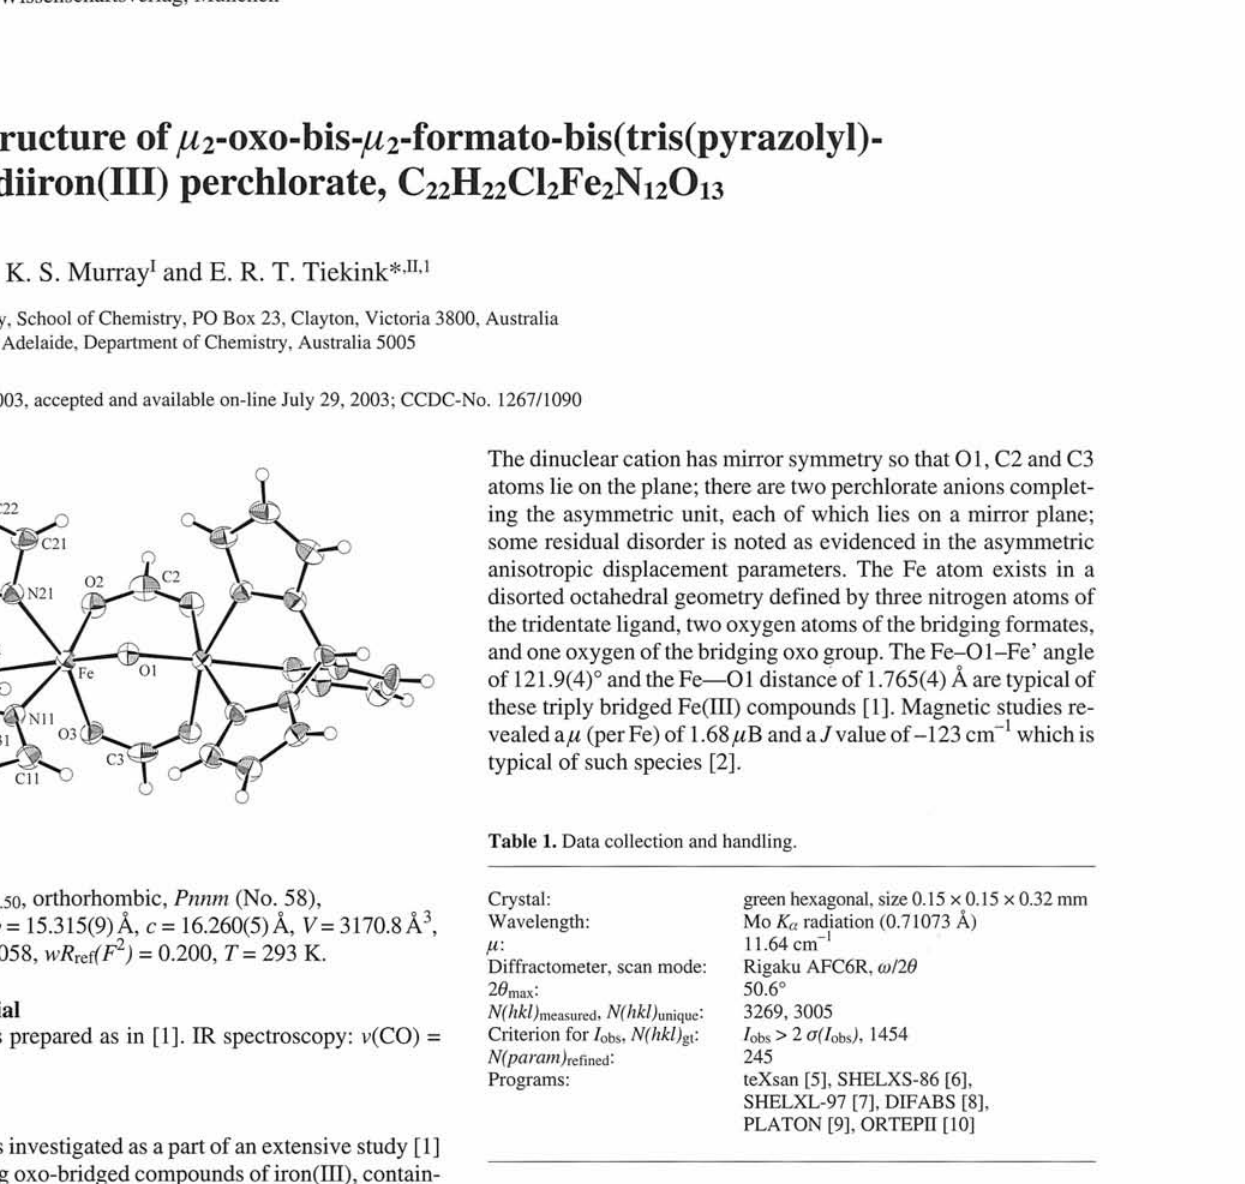
Table 2. Atomic coordinates and displacement parameters (in Â 2